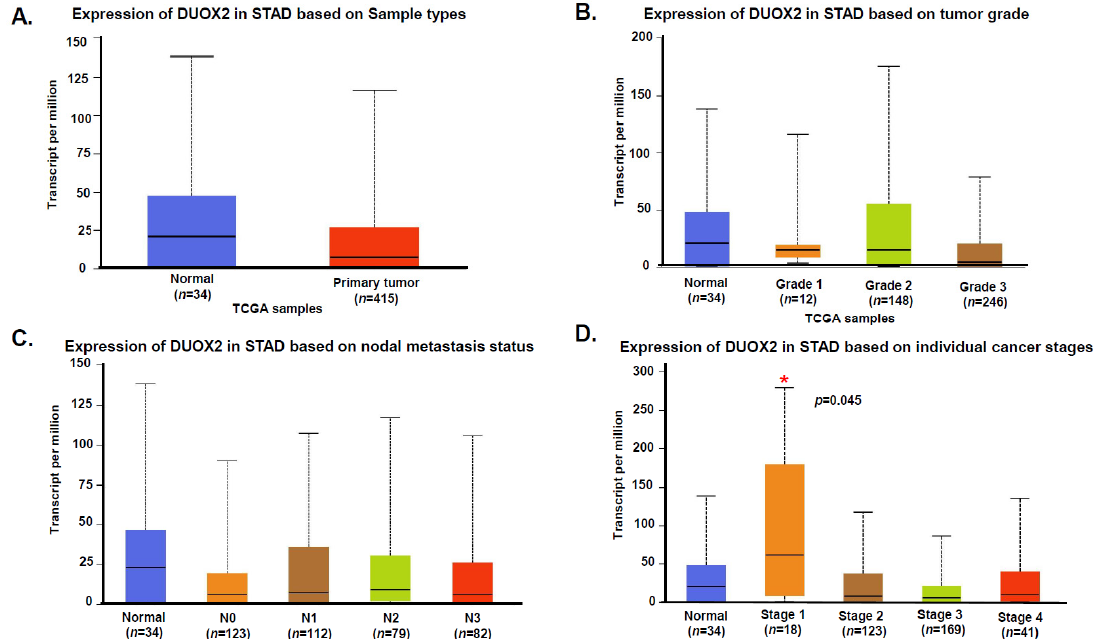
Figure 5. TCGA data of DUOX2 mRNA expression in human Stomach adenocarcinoma (STAD) tumors. ( A ) Levels of DUOX2 mRNA expression in 34 Normal and 415 Primary stomach adenocarcinoma. ( B ) Levels of DUOX2 mRNA expression based on tumor grade. The number of samples of each tumor grade are indicated in parenthesis. ( C ) Levels of DUOX2 mRNA expression based on nodal metastasis status. ( D ) Expression of DUOX2 mRNA based on individual cancer stages. Data provided by the UALCAN web resource for analyzing cancer OMICS data (http://ualcan.path.uab.edu/index.html [24], accessed on 28 July 2021). Significance of difference estimated by Student’s t -test considering unequal variance. * p < 0.05.